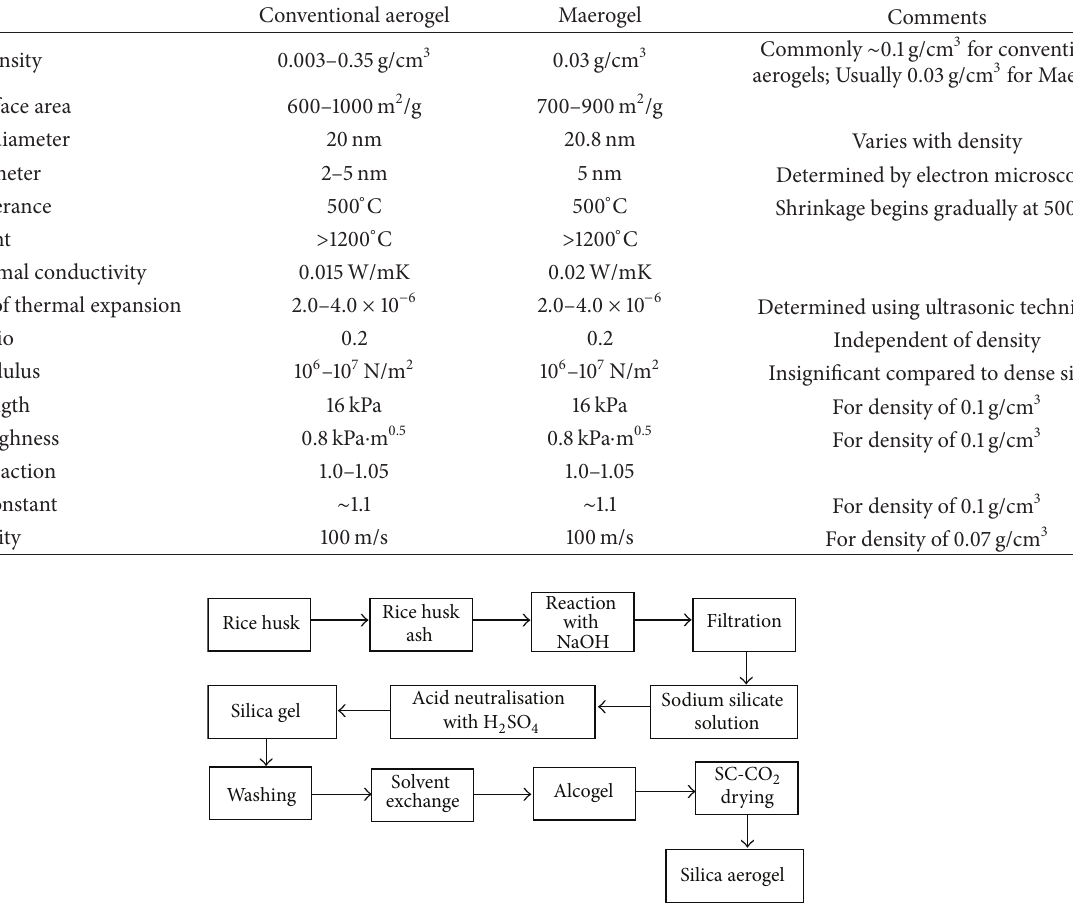
Table 1: Physical properties of conventional silica aerogel and Maerogel.